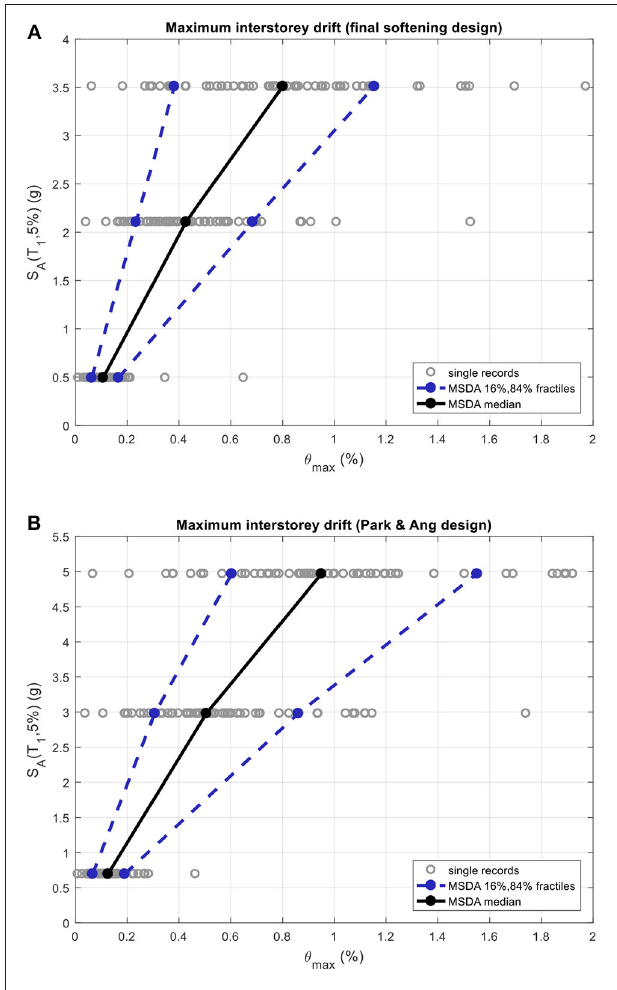
FIGURE 4 | Three-story—multi-stripe dynamic analysis with reference to the maximum drift for (A) final softening and (B) Park and Ang